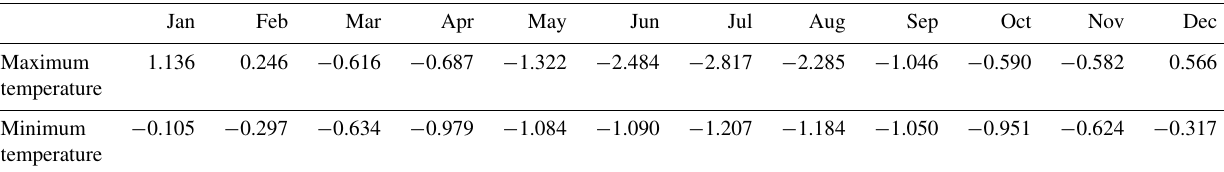
Table 4. The average QM adjustments at the monthly timescale applied to daily maximum- and minimum-temperature data at Tianjin Meteorological Observation Station (unit – ◦